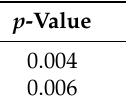
Table 3. Binary logistic regression analysis of serum SELENBP1 and VCL for CAS diagnosis in clinic. Odds ratio represents the risk change per 10 unit increase of